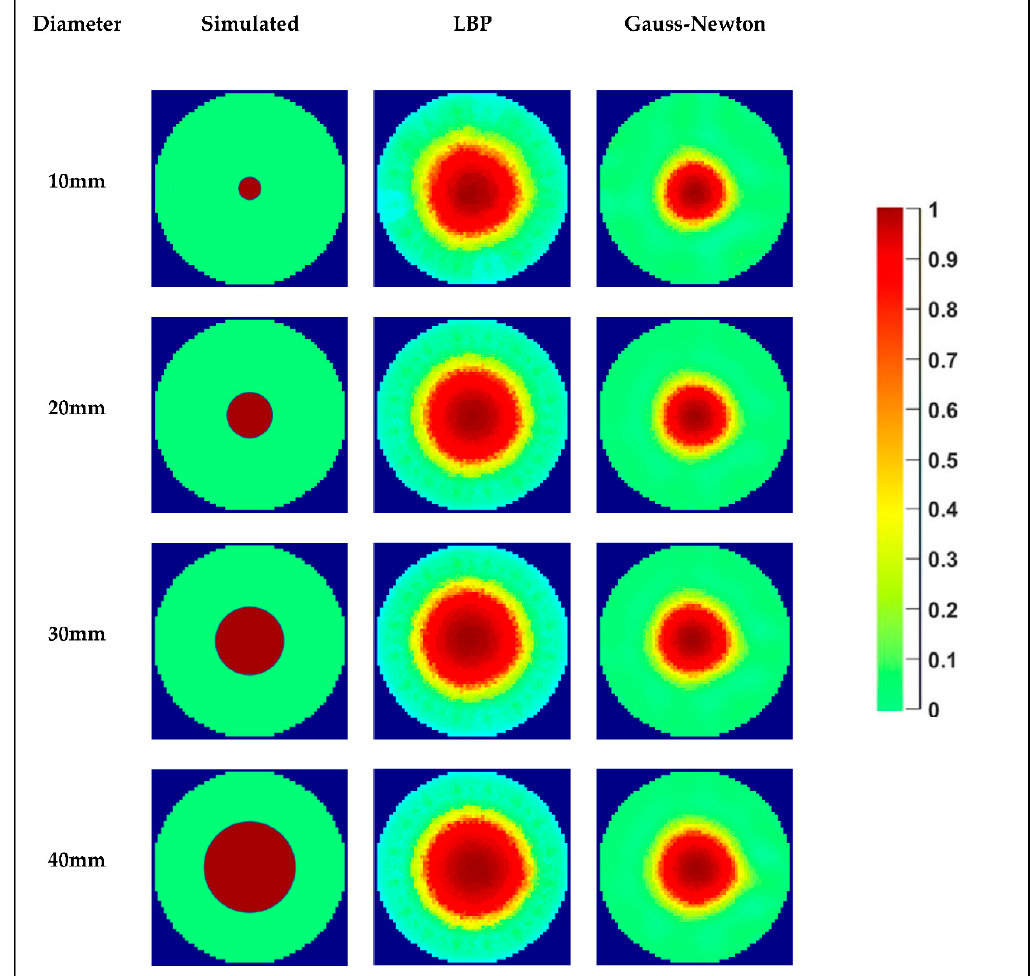
Figure 14. Image Reconstruction based on static tests: Row 2 (Column 2-Column 4) Case 10 mm: Simulated image, LBP reconstruction, and GN reconstruction. Row 3 (Column 2–Column 4) Case 20 mm: Simulated image, LBP reconstruction, and GN reconstruction. Row 4 (Column 2–Column 4) Case 30 mm: Simulated image, LBP reconstruction, and GN reconstruction. Row 5 (Column 2–Column 4) Case 10 mm: Simulated image, LBP reconstruction, and GN reconstruction. Column 5: Colormap.